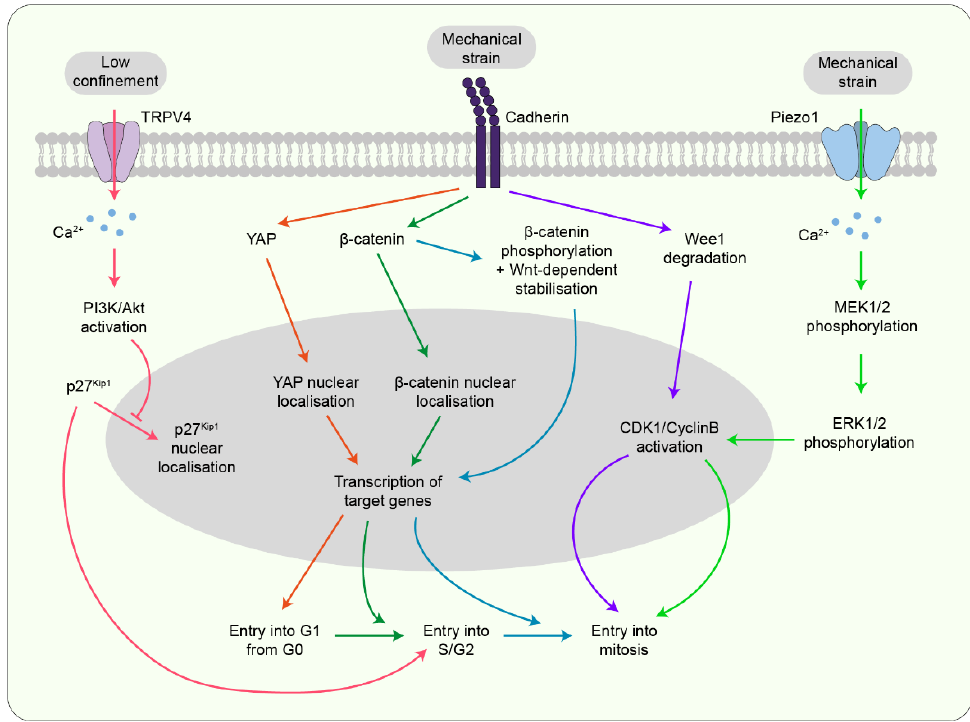
Figure 5. Transmembrane proteins sense mechanical forces to influence cell proliferation. Mechanosensitive channels such as Piezo1 and TRPV4 as well as cadherins act as signalling centres to influence cell divisions via control of the cell cycle at different checkpoints. Coloured arrows indicate different pathways.